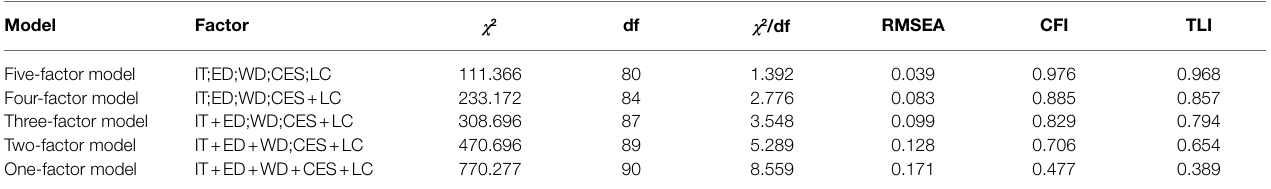
TABLE 1 | Results for confirmatory factor